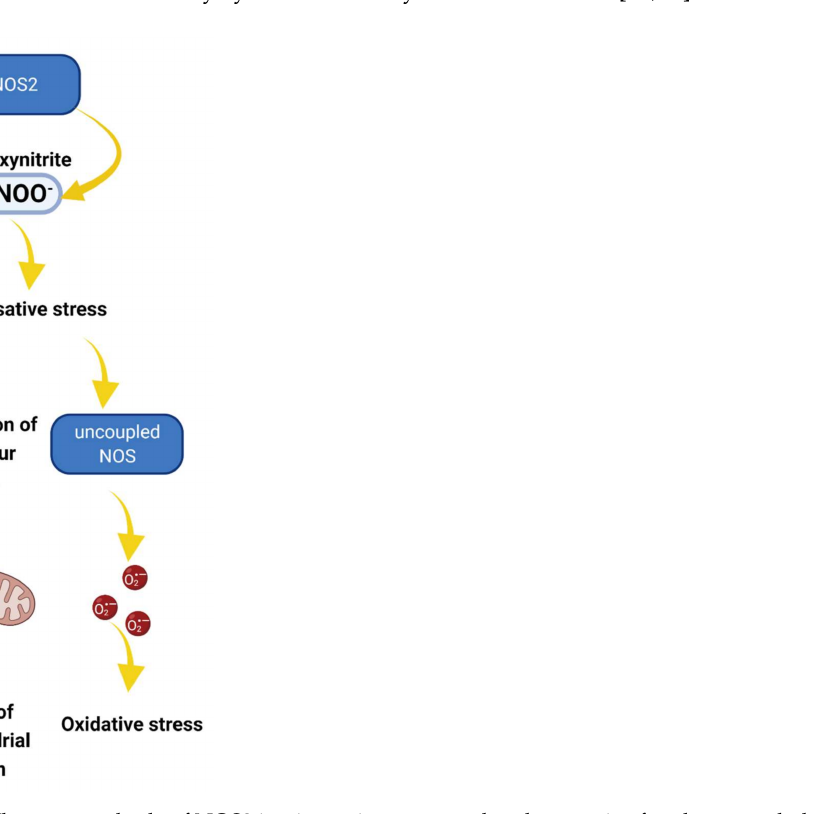
Figure 2. The proposed role of NOS2 in nitrosative stress and pathogenesis of podocyte and glomeru- lar diseases. Under pathological conditions such as hyperglycemia, cellular production of NO and reactive oxygen species (ROS) are increased, promoting peroxynitrite (ONOO − ) production [50]. Per- oxynitrite and other reactive nitrogen species oxidatively inactivate different mitochondrial proteins, affecting the iron–sulfur centers and altering mitochondria function. Alternatively, nitrosative stress results in NOS uncoupling, further increasing O 2 − production and oxidative stress [51]. Overall, the cascade of events may alter mitochondria activity and promote redox imbalance leading to irreversible damage and podocyte